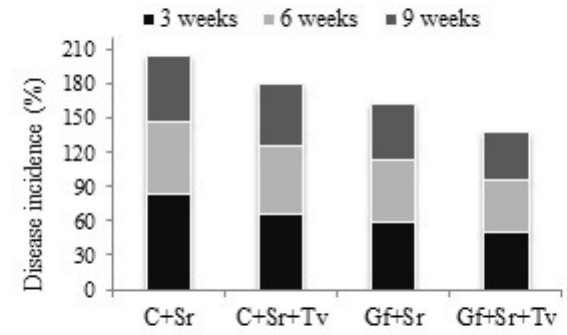
Fig 1. Incidences of disease in groundnut (W-51) due to inoculation of G. fasciculatum and T. viride . Mean values (n=3 ± SD). C+Sr: Control+ S. rolfsii , C+Sr+Tv: Control+ S. rolfsii + T. viride , Gf+Sr: G. fasciculatum + S. rolfsii , Gf+Sr+Tv: G. fasciculatum + S. rolfsii + T.